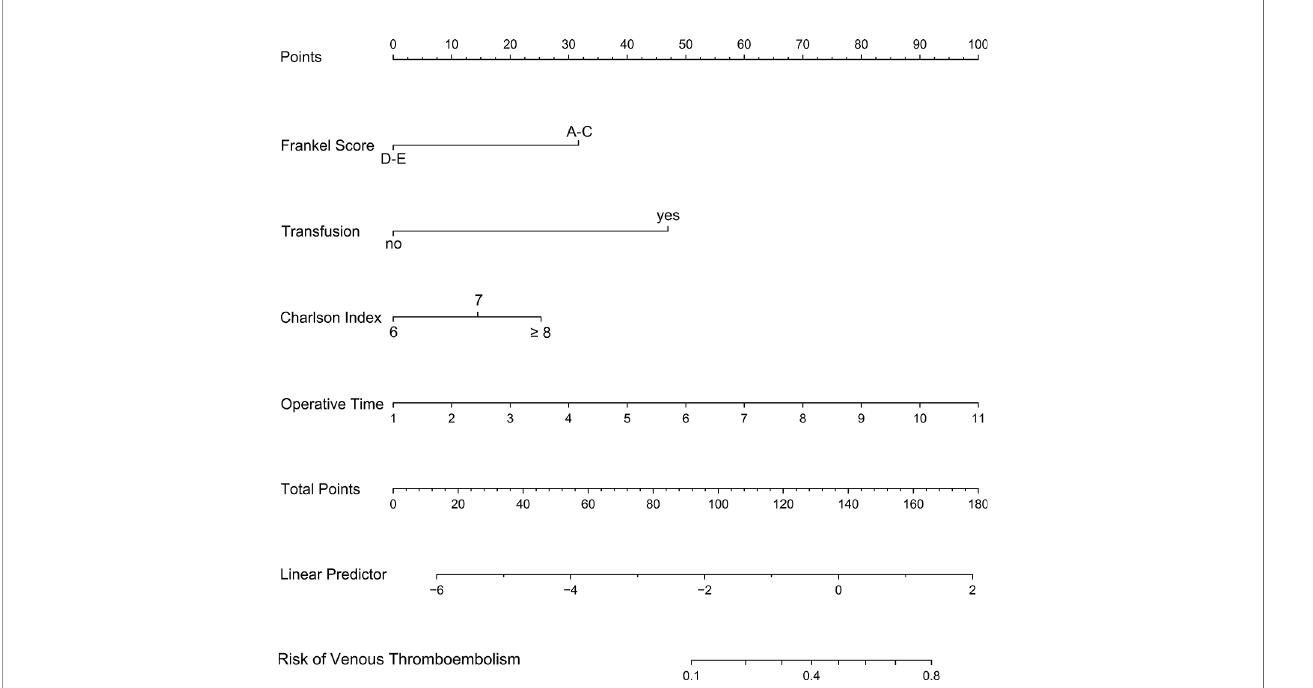
FIGURE 2 | A nomogram model was established using independent risk factors screened out by multivariate regression analysis. The corresponding score for each factor is based on the condition of the patient, which can be determined by making a vertical line upwards (e.g., a patient with blood transfusion will receive between 40 and 50 scores). Add all the scores to get the total score, then fi nd the corresponding point on the total points axis and make a vertical line down to predict the risk of the VTE within 90 days after spinal metastasis surgery.